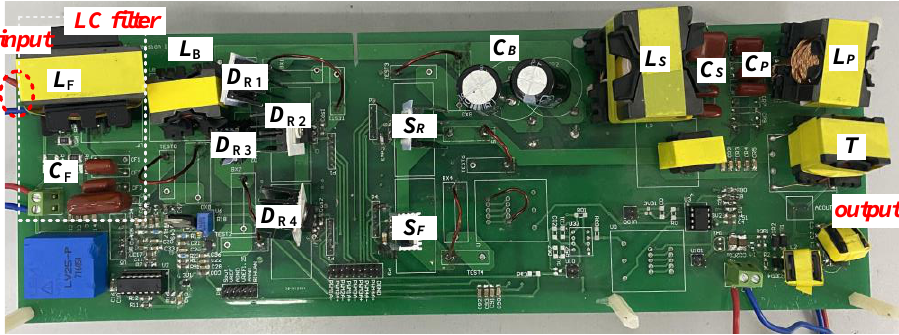
Figure 18. The prototype of the single-stage AC/AC converter.